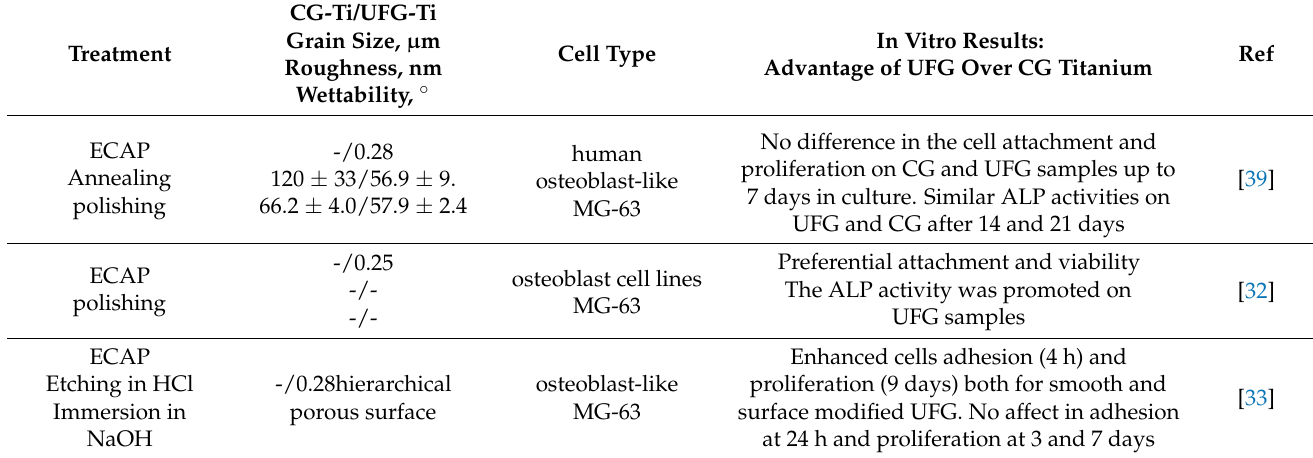
Table 4. Affect an UFG structure on in vitro cellular